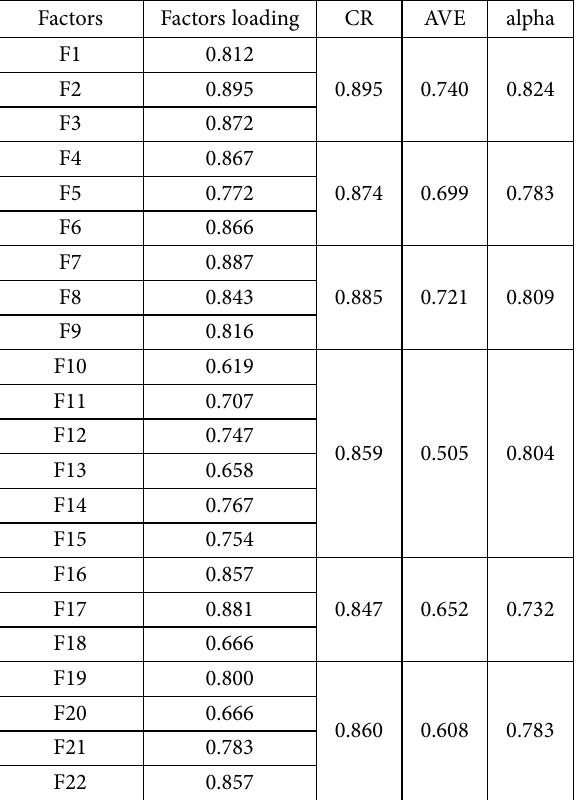
Table 3. Results of confirmatory factor analysis